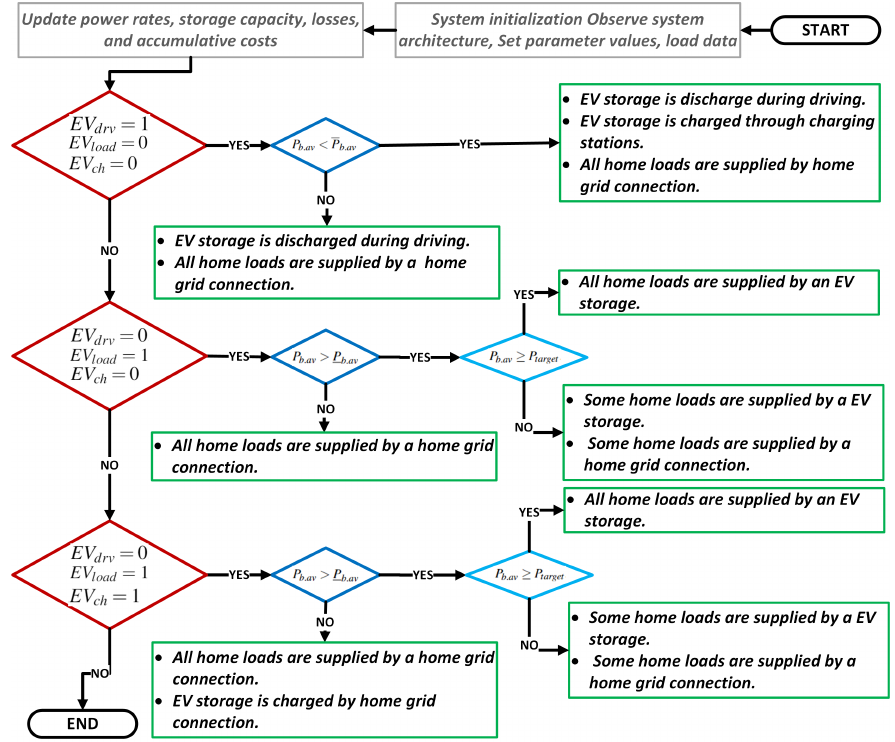
Figure 3. Flowchart of the conventional rule-based scheduling scheme